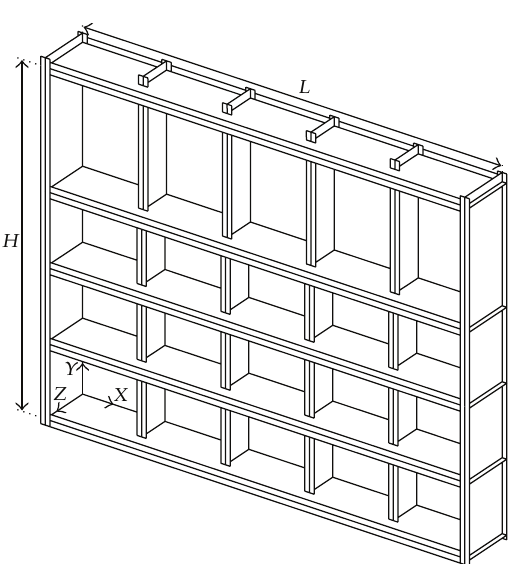
Figure 2: Three-dimensional representation of the considered type of gate.